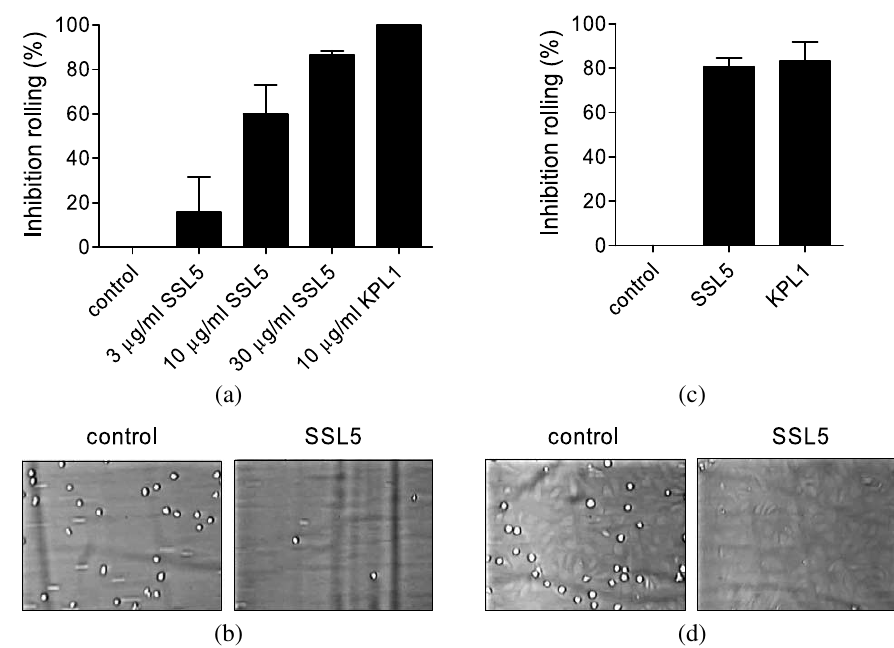
Fig. 3. SSL5 inhibits HL-60 cell rolling on P-selectin and endothelial cells. (a and b) Coverslips were coated with P-selectin and HL-60 cells pretreated with 0–30 µg/ml SSL5 or 10 µg/ml KPL1 for 15 min at 37 ◦ C were perfused for 5 min. After washing, accumulated HL-60 cells were quantified to assess rolling adhesion of the cells. (c and d) Freshly isolated HUVECs were cultured on glass coverslips. After stimulation of HUVECs with 100 µM histamine for 3 min for P-selectin surface expression, HL-60 cells pretreated with 30 µg/ml SSL5 or 10 µg/ml KPL1 for 15 min at 37 ◦ C were perfused for 5 min. The data of the antagonists were calculated relative to control-treated cells and are mean values ± SEMs of 3 independent experiments. Screen shots represent control- and SSL5-treated HL-60 cell rolling after 5 min of perfusion over a P-selectin (b) and endothelial cell surface (d).